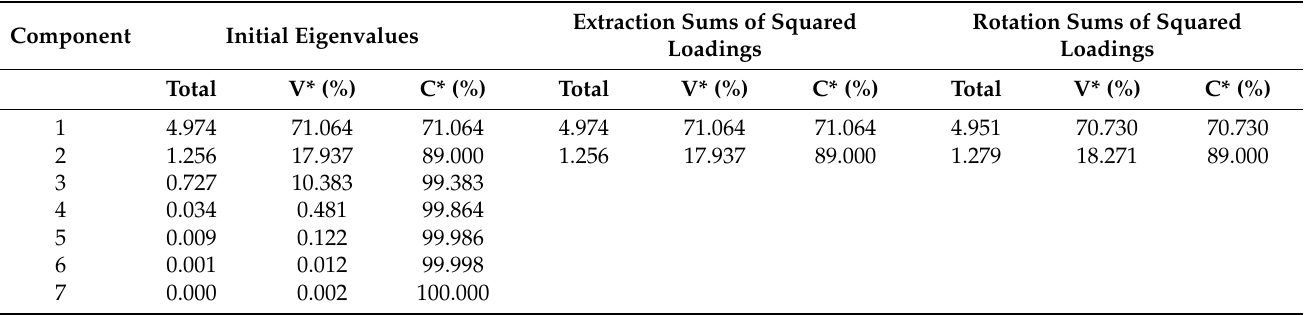
Table 2. Total variance